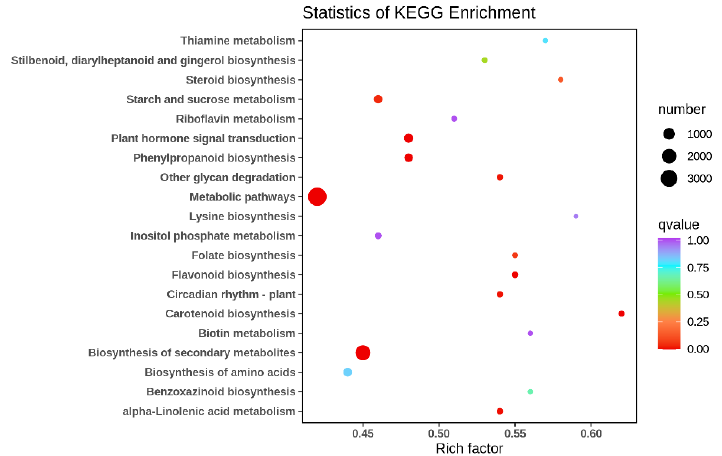
Figure 5. Scatter plot of differential gene KEGG enrichment in G type and N type.